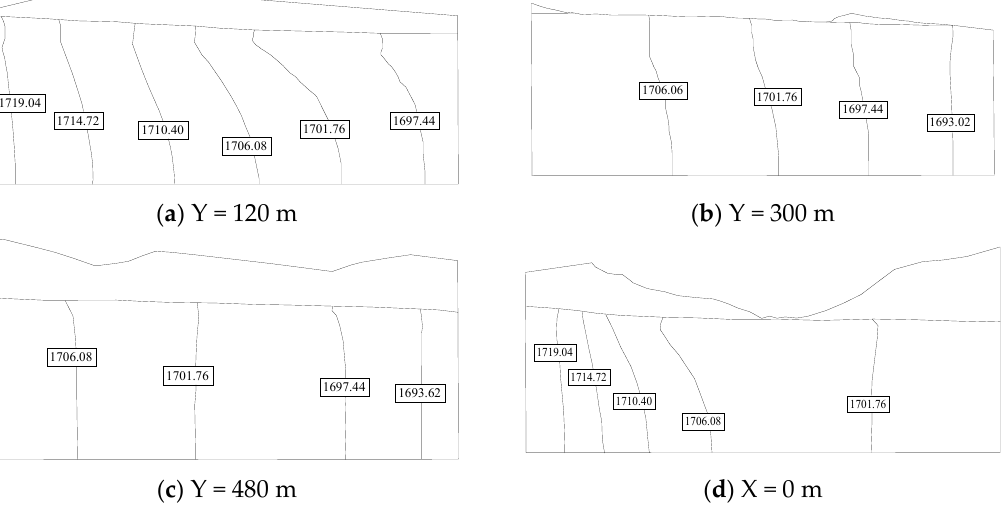
Figure 9. Groundwater potential map of the natural period profile of the Hami concrete-face rockfill dam. The unit of water level in the figure is in meter.